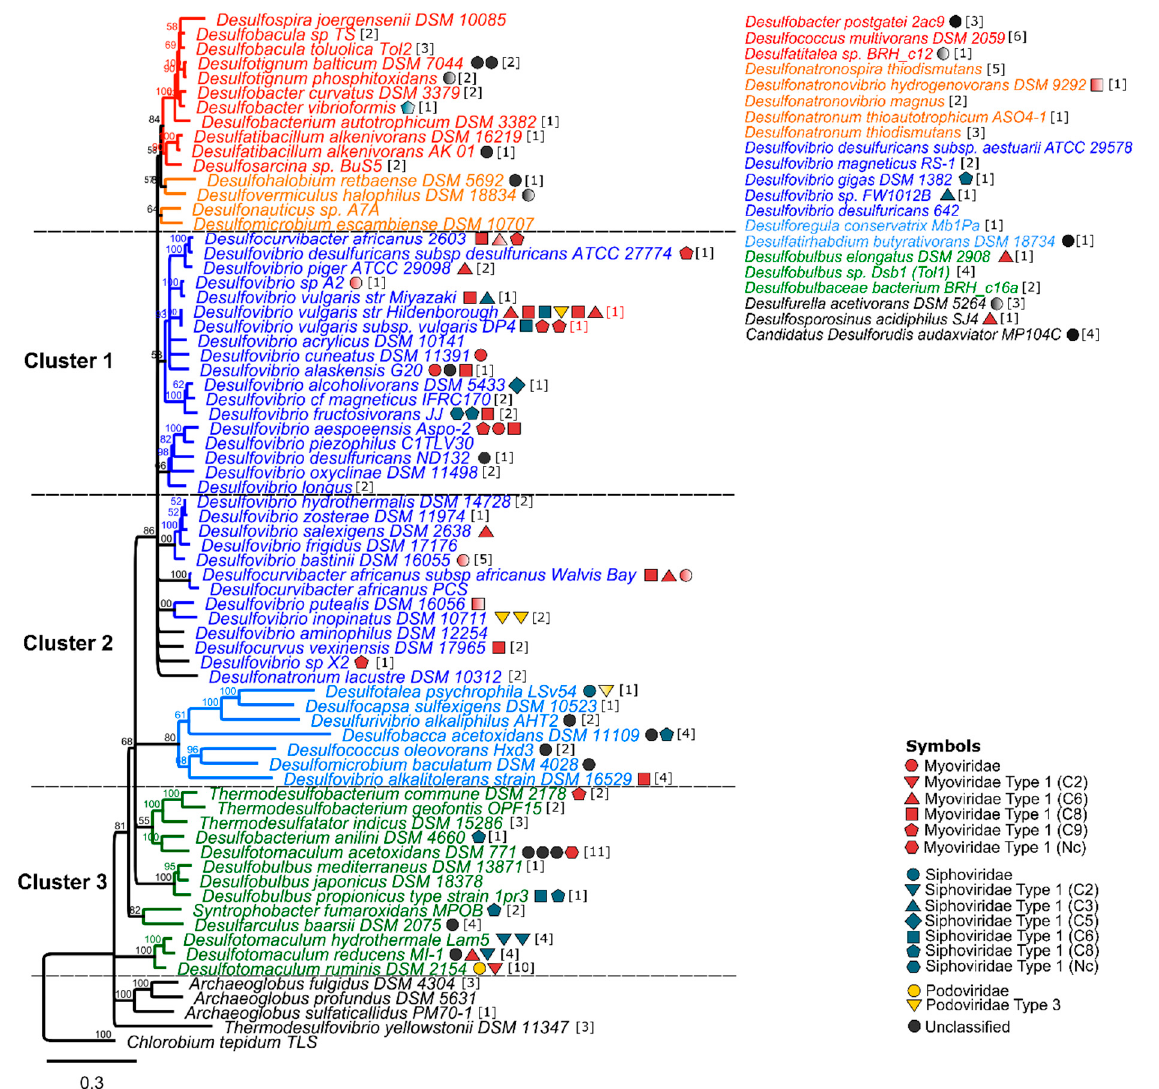
Figure 1. Distribution of prophages and CRISPR arrays found in SRP. The Neighbor-joining phylogeny of the DsrAB dissimilatory (bi)sulfite reductases sequences of 70 out of 91 SRP analyzed by this study. DsrAB dissimilatory (bi)sulfite reductases amino acid sequences were obtained from NCBI database and aligned using MUSCLE algorithm and manually curated in Geneious to a final alignment of 523 unambiguously aligned positions. The tree was rooted with the oxidative bacterial type DsrAB sequence obtained from Chlorobium tepidum as outgroup. Scale bar indicates 30% sequence divergence. Consensus support (%) is shown next to each node. Colored branches indicate families as the following. Red branches include strains belonging to Desulfobacteraceae; orange, include strains belonging to Desulfohalobiaceae, Desulfomicrobiaceae; blue, include strains belonging to Desulfovibrionaceae and Desulfonatronaceae; light blue, included strains belonging to Desulfobulbaceae, Syntrophacea, Desulfomicrobiaceae and Desulfovibrionaceae, green include strains belonging to Thermodesulfobiaceae, Desulfobacteraceae, Peptococcaceae, Desulfobulbaceae, Syntrophobacteraceae and Desulfarculaceae; and black branches include strains belonging to Archaeoglobaceae and Nitrospiraceae. Prophages are indicated after each lysogen by symbols and colors according to the Virfam, based on the classification of the ACLAME bacteriophages. Degrading colors indicate prophages were classified as small (<30 kb). The number of CRISPR elements found in each SRP is shown as a number in brackets. Twenty-one strains shown in the upper-right corner of the figure were excluded of the phylogeny due to either intact DsrAB sequences were not found in the genomes of those strains or presented high discrepancies with previous studies [56].